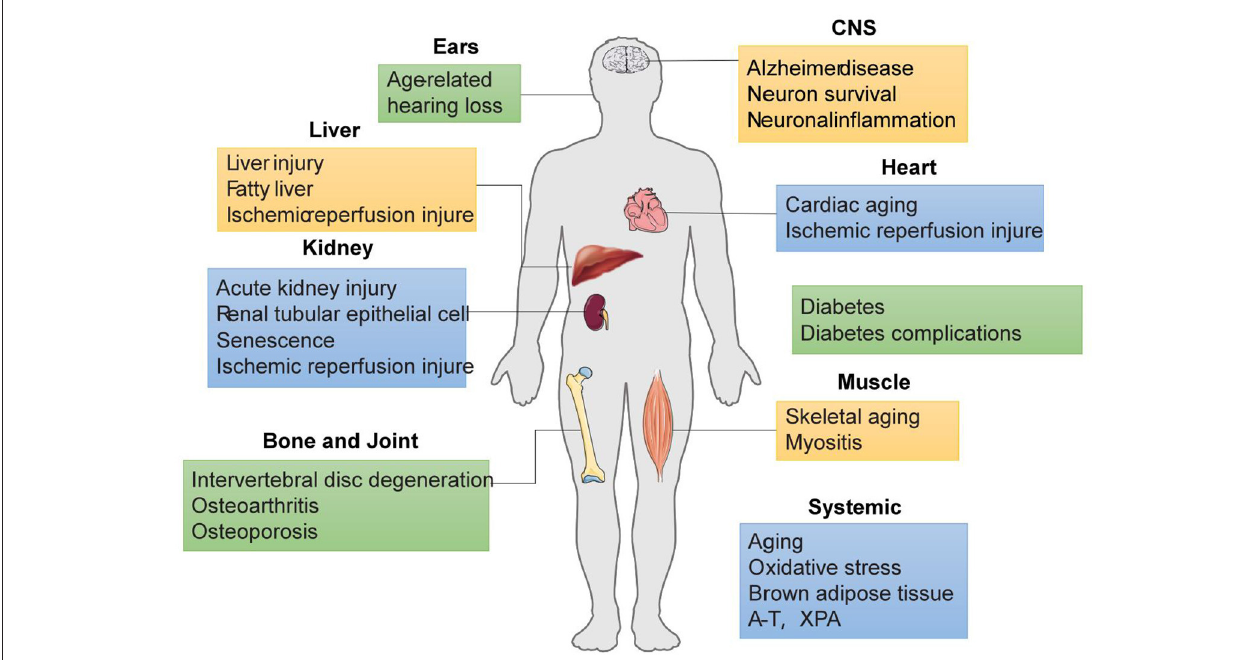
FIGURE 3 | SIRT-medidated mitophagy in age-related